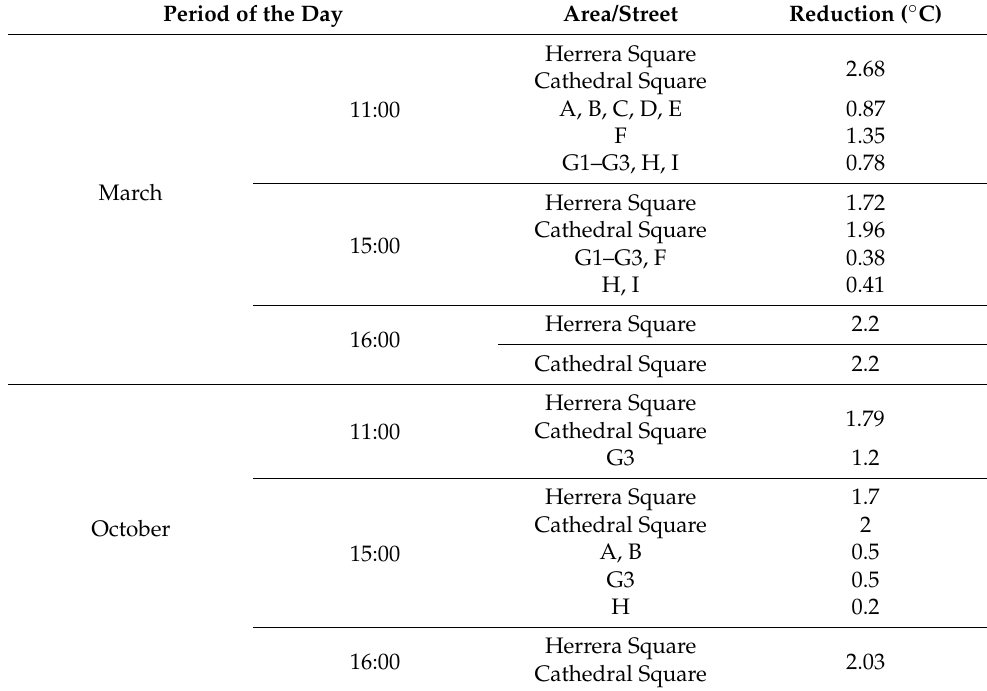
Table 4. Comparison of air temperature for base case and case 2 by streets for critical months. Period of the